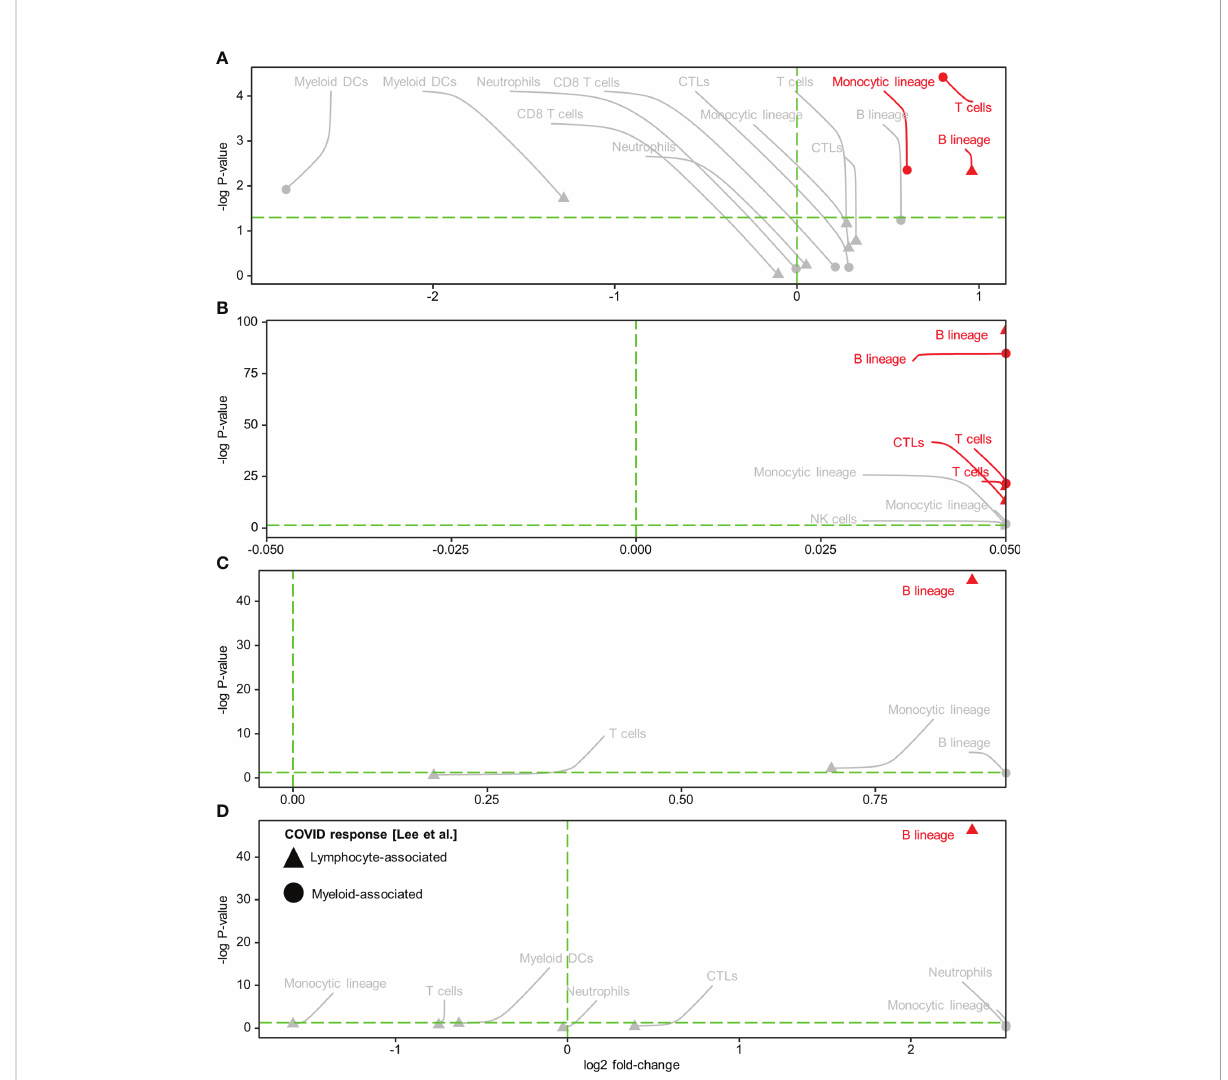
FIGURE 3 Spatial colocalization of immune cell types and COVID immune response. (A – D) Immune cell types (determined by a deconvolution-based microenvironment cell population-counter) and COVID immune responses (quanti fi ed as enrichment scores for the COVID response- associated gene signatures reported in Lee et al. (15) within the viral-high regions in HCC (A) and CRC (C) tumors and the corresponding adjacent normal tissues ( B , D , respectively). Lymphocyte and myeloid-associated COVID responses are represented by triangles and circles, respectively. The vertical green dashed line delineates log-fold change (FC) = 0 (log-FC > 0 for cell types with higher COVID immune scores in Visium spots where the immune cell type was detected than in spots where it was not detected). The horizontal green dashed line represents P = 0.05; above the line , P < 0.05. Red text and annotations represent P < 0.005. P -values were computed using the Kruskal-Wallis test. CTLs, cytotoxic lymphocytes; DCs, dendritic